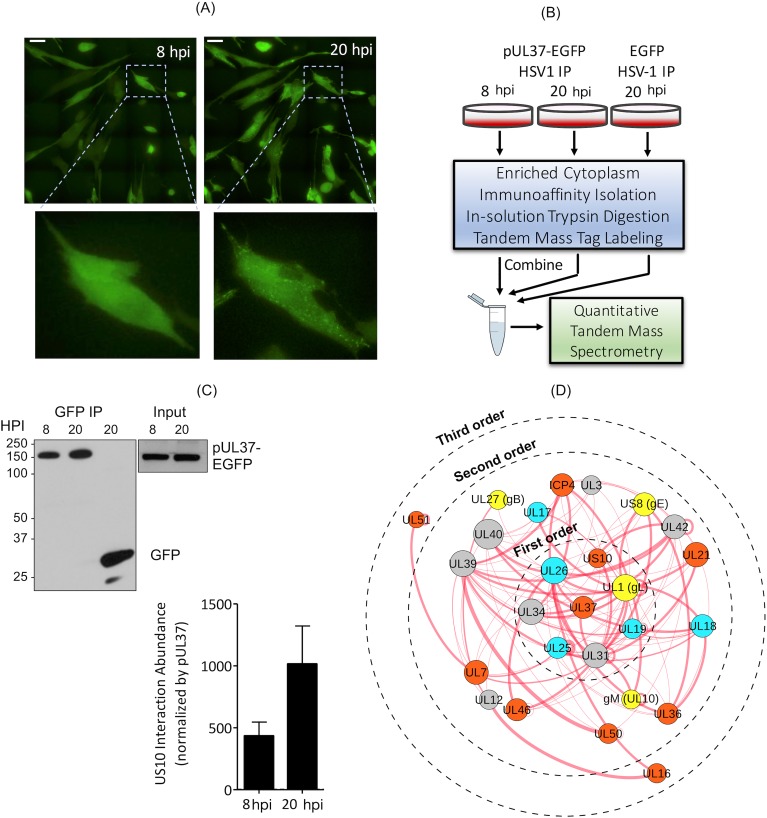
Experimental validation of the pUL37–pUS10 interaction in HSV1-infected primary human fibroblasts.(A) Visualisation of pUL37-EGFP during HSV1 infection of human foreskin fibroblasts using live-cell epifluorescence microscopy. Images show a representative field of infected cells at 8 and 20 HPI. Zoomed images show localisation of pUL37-EGFP (green) in the same cell at 8 and 20 HPI. Scale bar = 50 μm. (B) IP–MS workflow. Human fibroblasts were synchronously infected (multiplicity of infection = 10) with either pUL37-EGFP or EGFP HSV1, with two replicates per condition. HSV1-UL37GFP was collected at 8 and 20 HPI and HSV1-GFP at 20 HPI (HSV1-GFP). pUL37-EGFP and its interactions were isolated from the cytoplasmic cell fraction by IP using anti-GFP antibodies. Proteins were digested with trypsin, and the resulting peptides from each sample were labelled with unique TMT reagents and then combined prior to nanoliquid chromatography–tandem MS analysis. (C) The recovery of pUL37-EGFP and EGFP in the immunoisolates was assessed by western blot with an anti-GFP antibody (S6 Table, columns S-V). 10% of each sample was analysed. The abundance of pUS10 interaction with pUL37 at 8 and 20 HPI (average ± range, N = 2). The relative amount of pUS10 was calculated by TMT–MS quantification and normalised by the respective pUL37 TMT abundance in each IP. (D) PPIs around pUL37 present in the reconstructed HSV1 network (Fig 2) and supported by IP results. EGFP, enhanced green fluorescent protein; gB, glycoprotein B; gE, glycoprotein E; GFP, green fluorescent protein; gL, glycoprotein L; gM, glycoprotein M; HPI, hours postinfection; HSV1, herpes simplex virus type 1; ICP, infected cell protein; IP, immunoaffinity purification; MS, mass spectrometry; PPI, protein–protein interaction; pUL, protein in unique long region; pUS, protein in unique short region; TMT, tandem mass tag; UL, unique long region; US, unique short region.